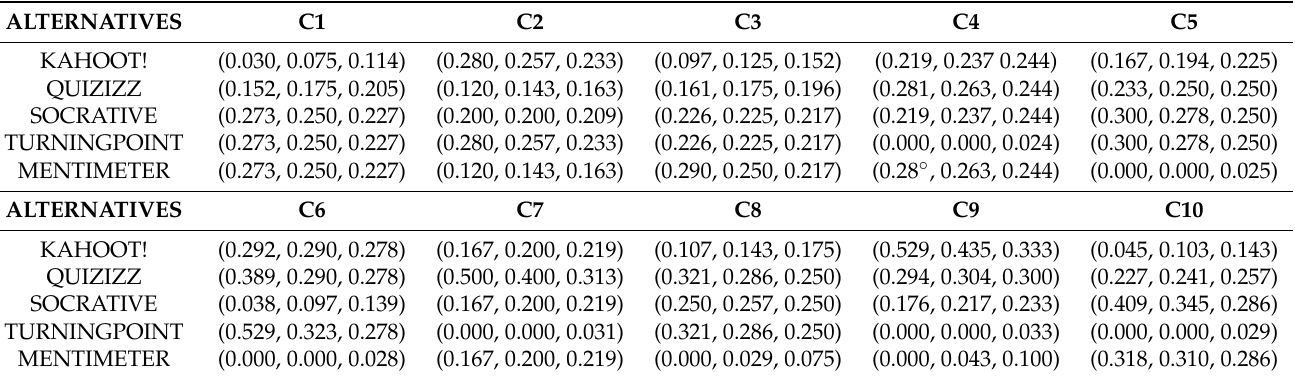
Table 6. The fuzzy Shannon entropy vector, the fuzzy diversification vector, and the fuzzy criteria weights obtained by applying Equations (24)–(26), after normalising the fuzzy criteria weights, respectively, are shown in Table 7. Table 6. The normalised decision